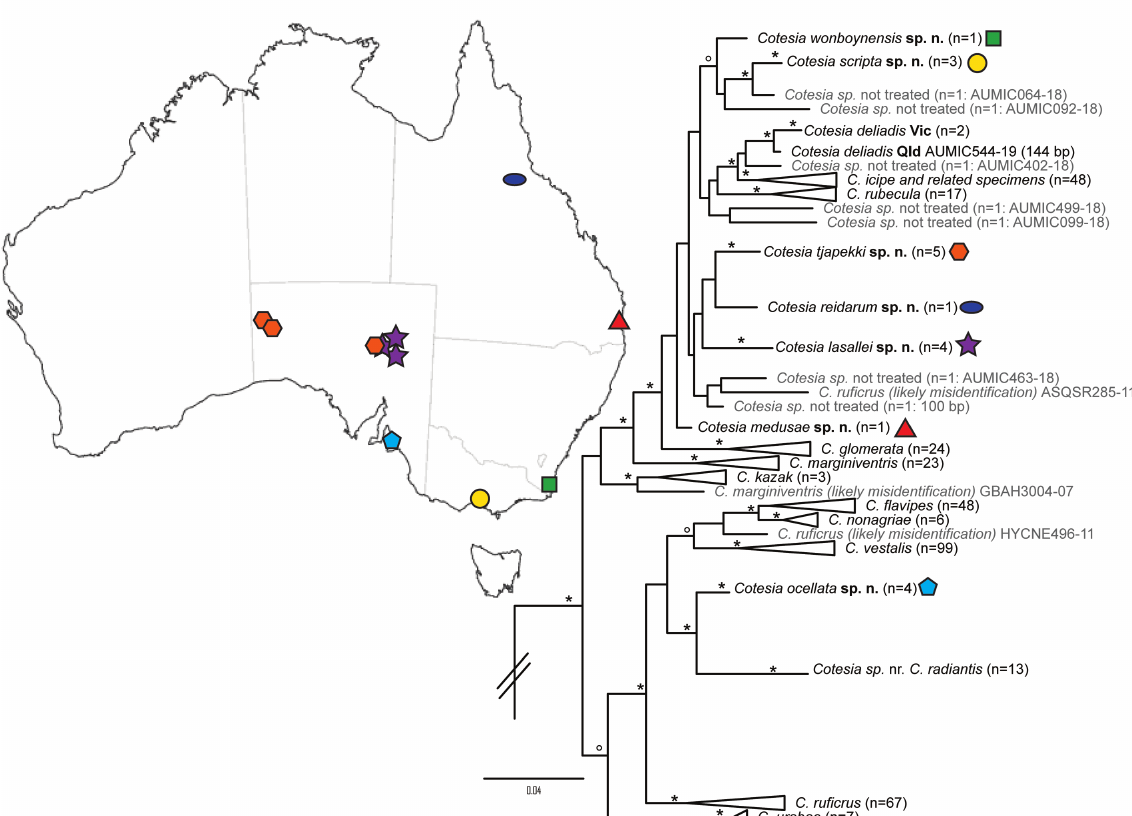
Fig. 1. Map of Australia showing the collection locations of the seven newly described species of Cotesia as well as a Bayesian phylogeny of these species and the other Cotesia spp. known to occur in Australia with publically available COI data. Species listed in black are those treated in this study, whilst those in grey are not treated due to being represented by single specimens, or are BOLD sequences that fall outside the rest of that species clade and are therefore possible misidentifications. BOLD codes for these single specimens are given at the end of the label in the tree. Symbols on the map correspond to the symbols on the phylogeny. Bayesian posterior probability values of ≥ 95 are represented by *, whilst those of 90–94 inclusive are represented by °. The number of sequences in collapsed clades are given in brackets (n = x). Outgroups have been removed for